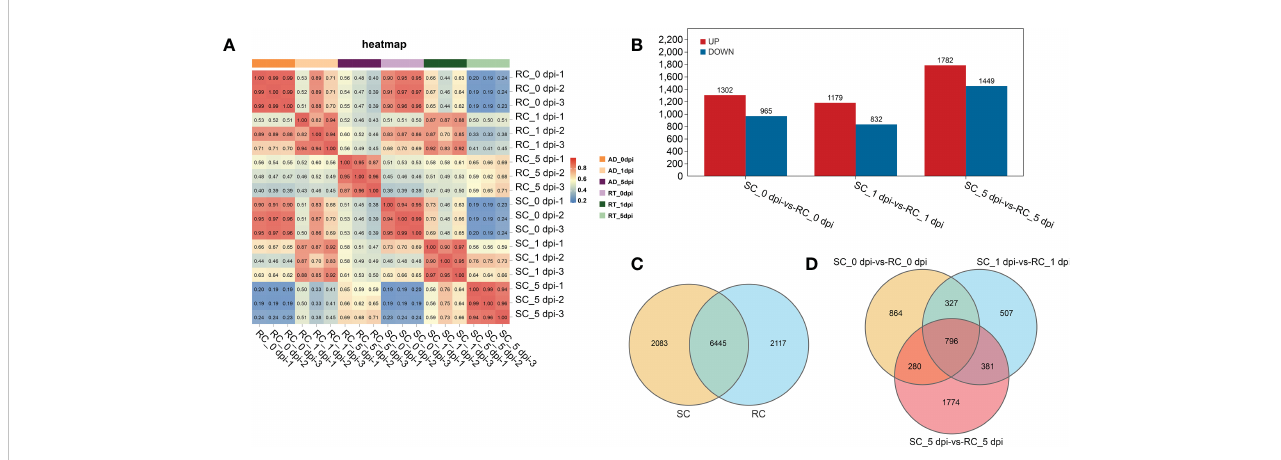
FIGURE 3 Analysis of the sample relationship and differentially expressed genes (DEGs) between groups. (A) Pearson correlation coef fi cients of all 18 samples; the correlation coef fi cients between the SC and RC were visually displayed as a heat map. (B) Up-regulation and down-regulation of DEGs. (C) A total of 2083 and 2117 DEGs were unique to the SC and RC, respectively. (D) DEGs in the SC compared to the RC at 0, 1, and 5